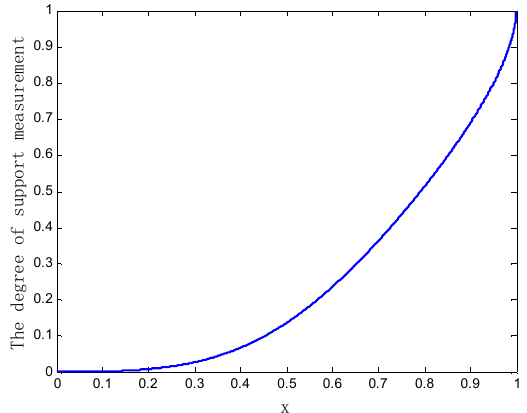
Figure 3. The variation curve of the mutual support degree between the evidence.